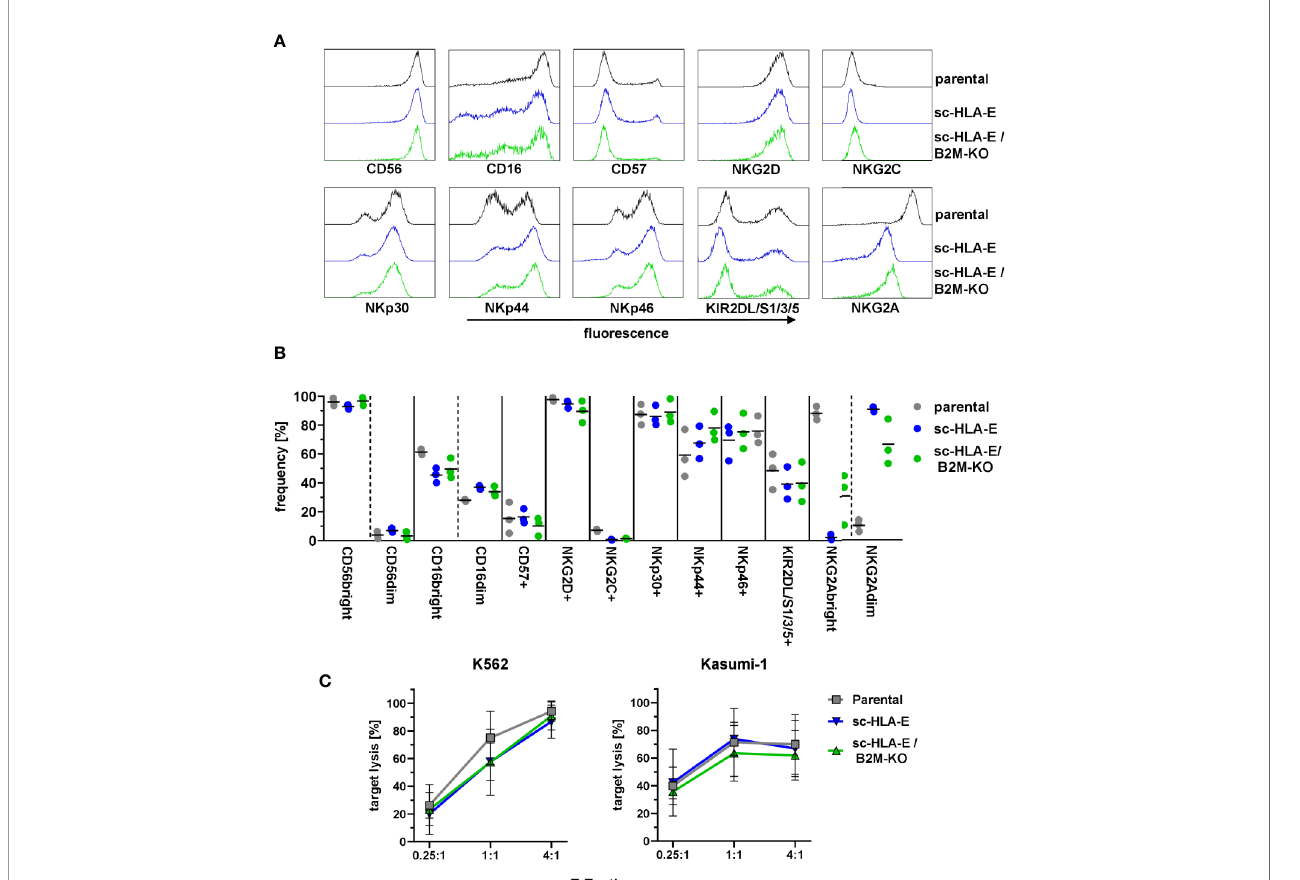
FIGURE 3 | Functional and phenotypical analysis of the gene modi fi ed NK cells. (A) Representative fl ow cytometry plots of the phenotypical analysis of the NK cell cultures. (B) Quanti fi cation of NK cell frequencies for phenotypic markers in parental, sc-HLA-E and sc-HLA-E/B2M-KO NK cell cultures from left to right for each marker (all data points shown, n = 3). (C) Quanti fi cation of natural NK cell cytotoxicity by lysis of the AML cell lines K562 and Kasumi-1 after co-incubation for 6 h. Statistical analysis was performed by two-way ANOVA with Holm-Sidak testing for multiple comparisons. No statistically signi fi cant differences could be detected (mean ± SD; K562: n = 6 for parental and sc-HLA-E/B2M-KO and n = 5 for sc-HLA-E NK cells; Kasumi: n = 4 for parental and sc-HLA-E/B2M-KO and n = 3 for sc- HLA-E NK